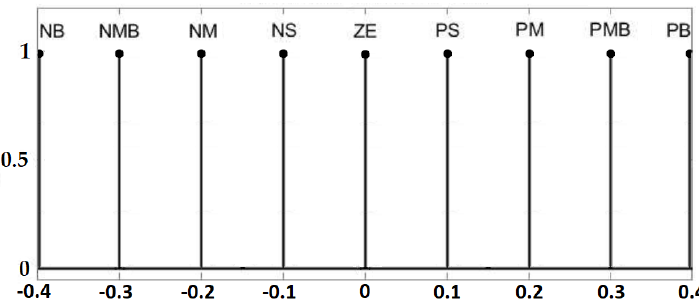
Figure 8. Fuzzy control membership functions for output pitch